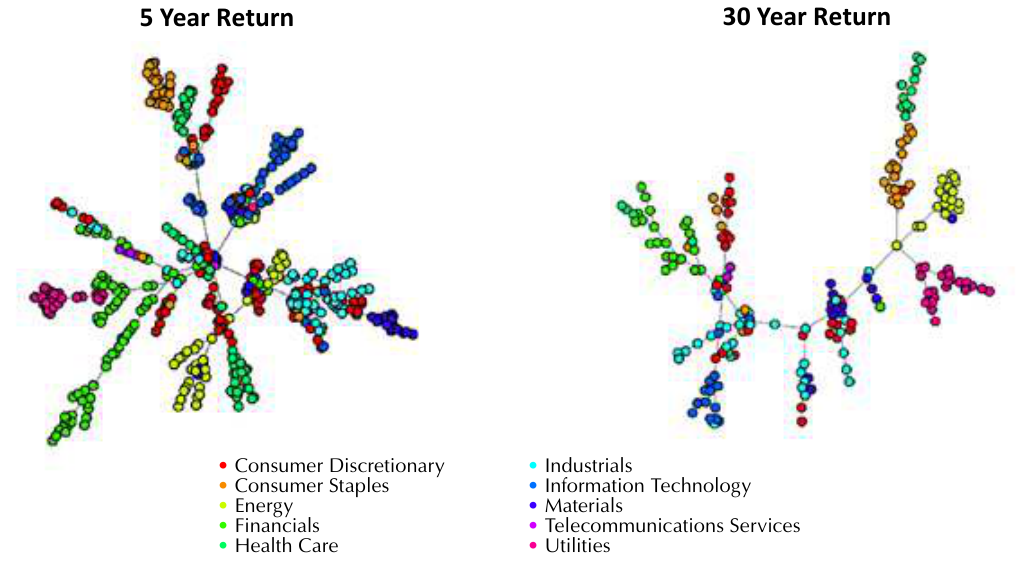
Figure 1. Comparison between minimum spanning trees of 5 and 30-year historical yield with color-coded